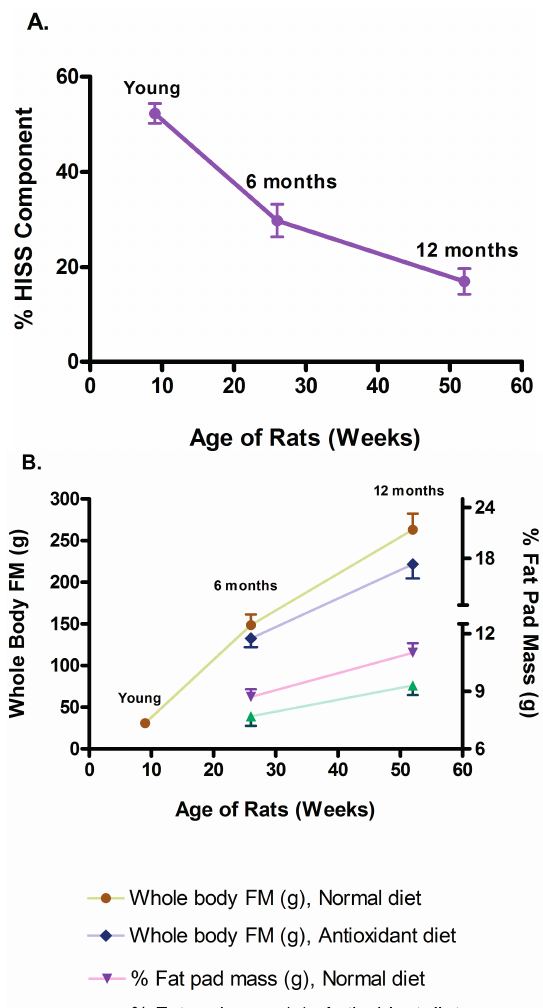
Figure 1. ( A ) The percentage (%) of HISS component decreased significantly as rats age increased from 9 to 52 weeks. p < 0.01: Young vs . 6 month, and 6 vs . 12 month groups [41]. ( B ) HISS action correlated negatively with whole body adiposity and all regional fat depots as rats age increased. Whole body fat mass (FM) and % Fat pad mass: p < 0.05: All 26 and 52 week old vs . young rats in the same group; 26 vs . 52 week old rats with normal diet. % Fat pad mass: p < 0.05: 52 week old rats with normal vs . antioxidant diet ([41] Table